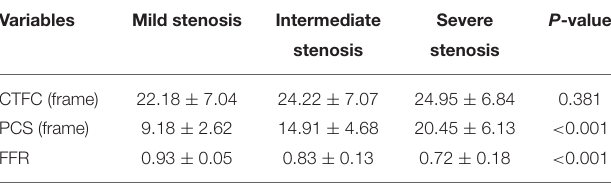
TABLE 3 | Angiographic patterns in vessels according to ICA.